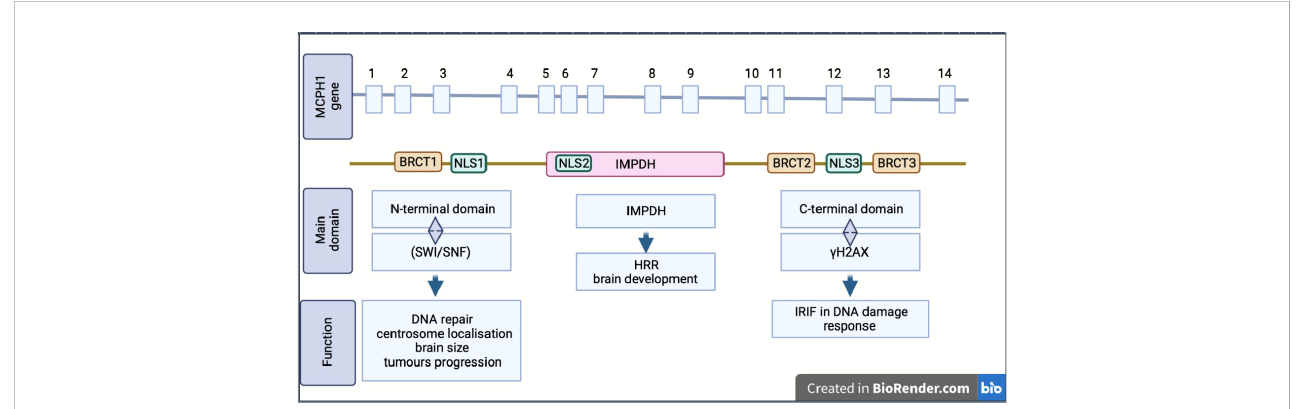
FIGURE 1 Schematic showing the structure, isoform and biological function of MCPH1/BRIT1. MCPH1/BRIT 1 gene consist of 14 exon and express Microcephalin protein which comprises of three BRCT domains, separated by variable linker regions. BRCT domains play an important role in MCPH1/BRIT1 functions and protein-protein interactions. Inosine 5 ′ -monophosphate dehydrogenase (IMPDH), Homologous recombination repair (HRR), Ionizing radiation induced foci (IRIF), nuclear localization signal or sequence (NLS), SWItch/Sucrose Non-Fermentable